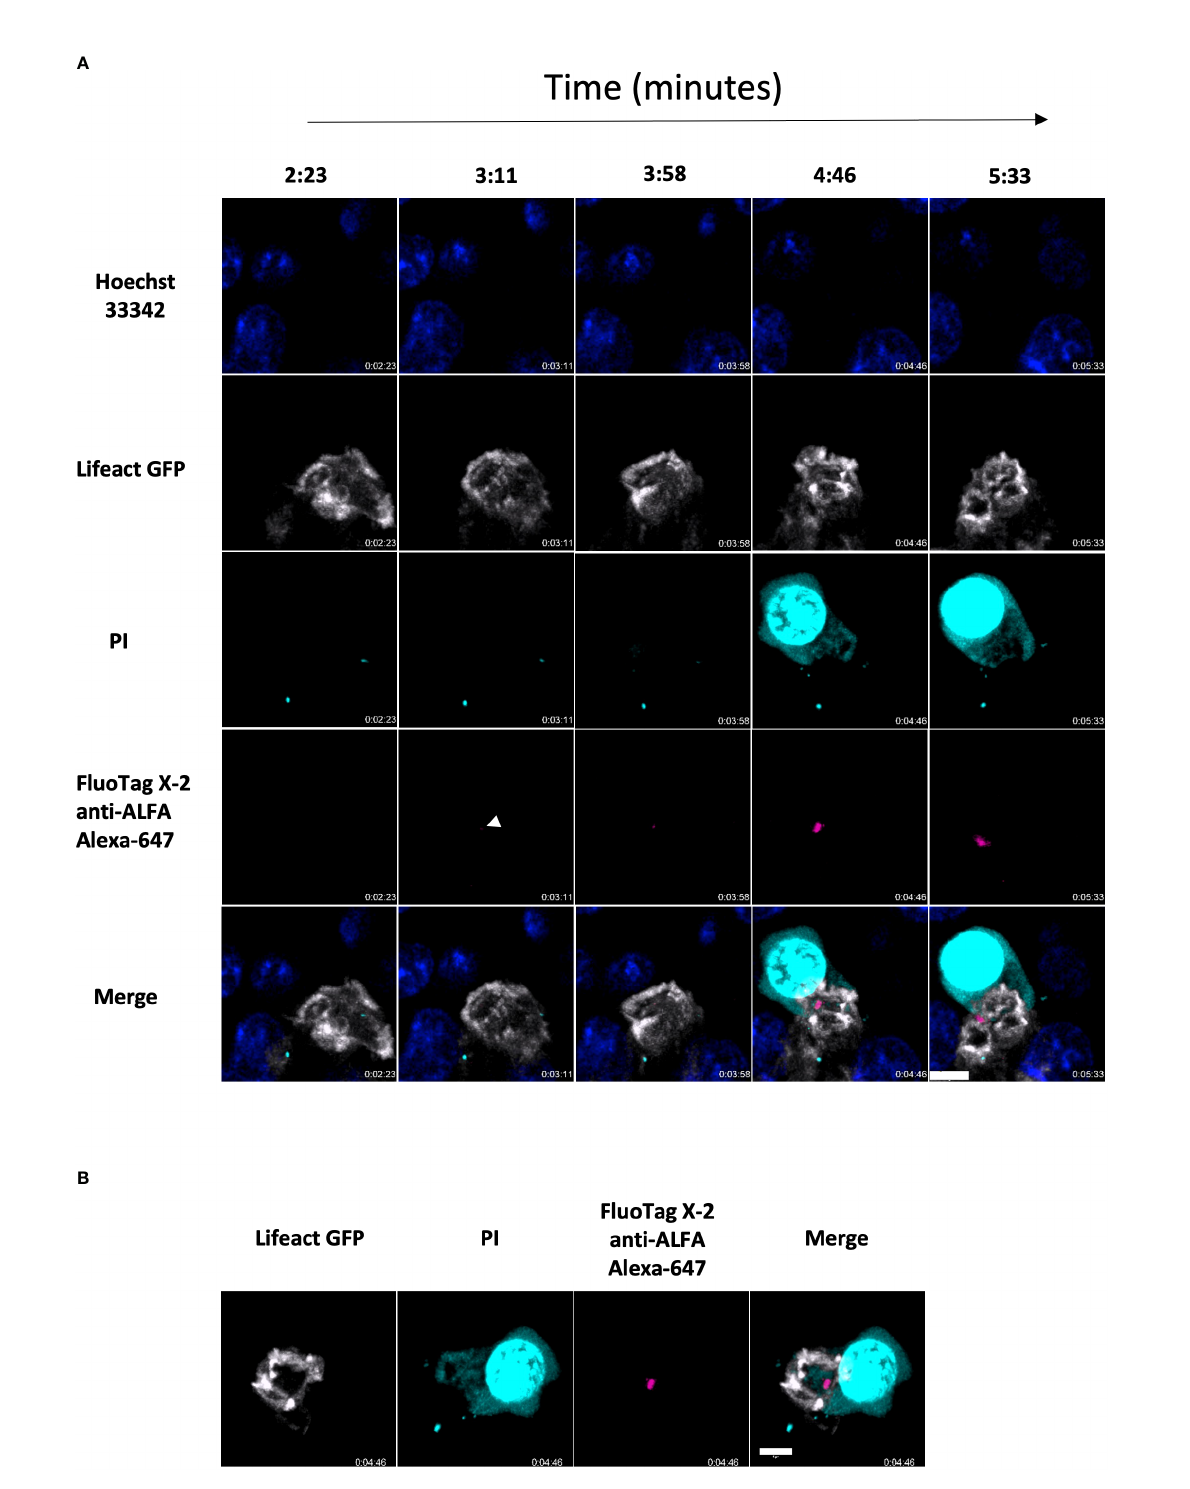
FIGURE 6 Synchronisation of ALFA-PRF-WT release from CD8 T cell with permeabilisation of the target cell membrane. (A) Side on montage showing release of ALFA-PRF-WT (magneta) in the area within the ring of actin depletion in the Lifeact GFP expressing Prf ko OTI CD8 T cells (grey) and the Hoechst 33342 labelled EL4 target cell, just prior to PI blush (cyan). White arrow head indicates point of fi rst ALFA-PRF-WT detection. Shown is a representative example from two fi elds of view (containing >5 synapse interactions each) of one biological replicate (mouse). (B) En face view of the synapse from timepoint 4:46 in a.) showing the location of the Perforin within the synapse area. Note, Hoechst 33342 was imaged only in the middle plane of the image, therefore was removed from display in this en face projection. Scale bars =